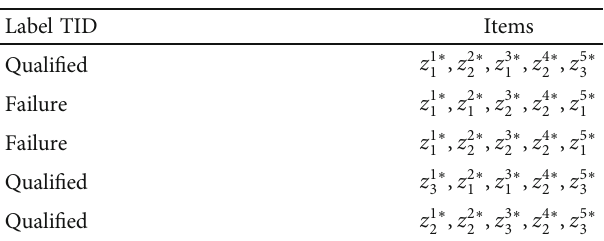
Table 3: Database Z . Label TID